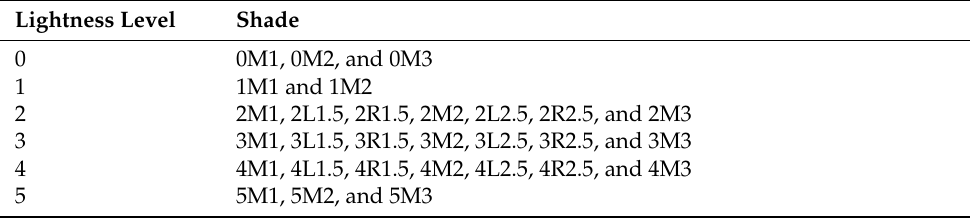
Table 3. Shades of the Toothguide 3D Master grouped into five groups of lightness